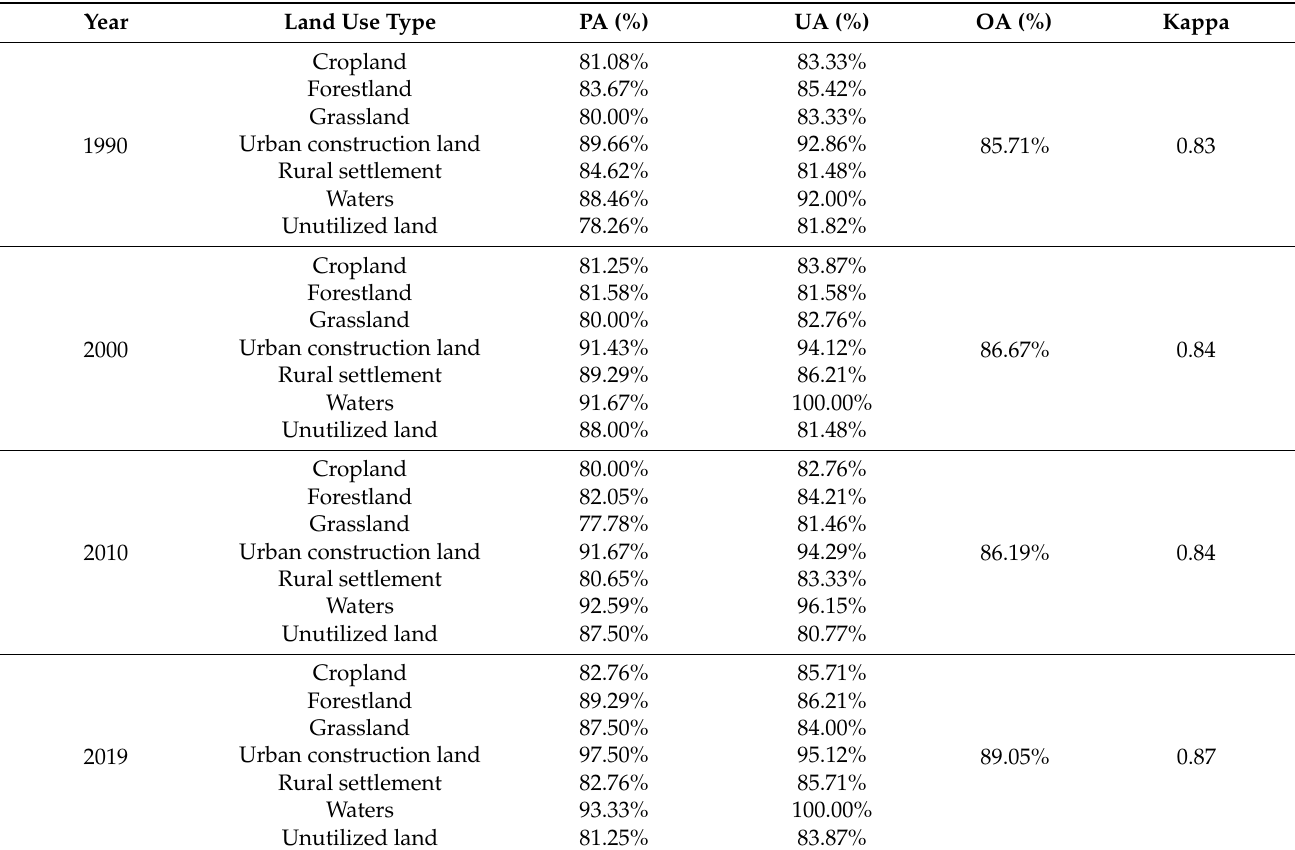
Table 1. Accuracy indices for the reclassified classes in the four